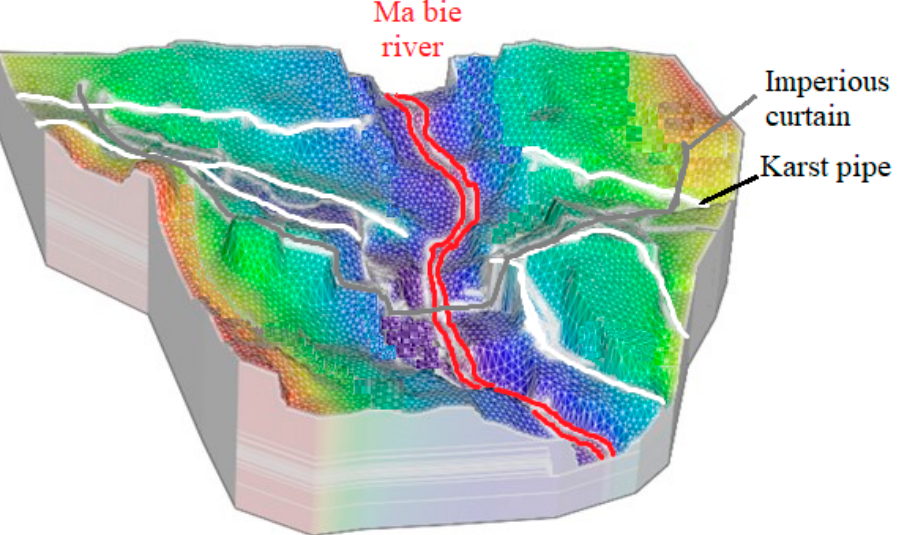
Figure 6. Finite element mesh of the model area.